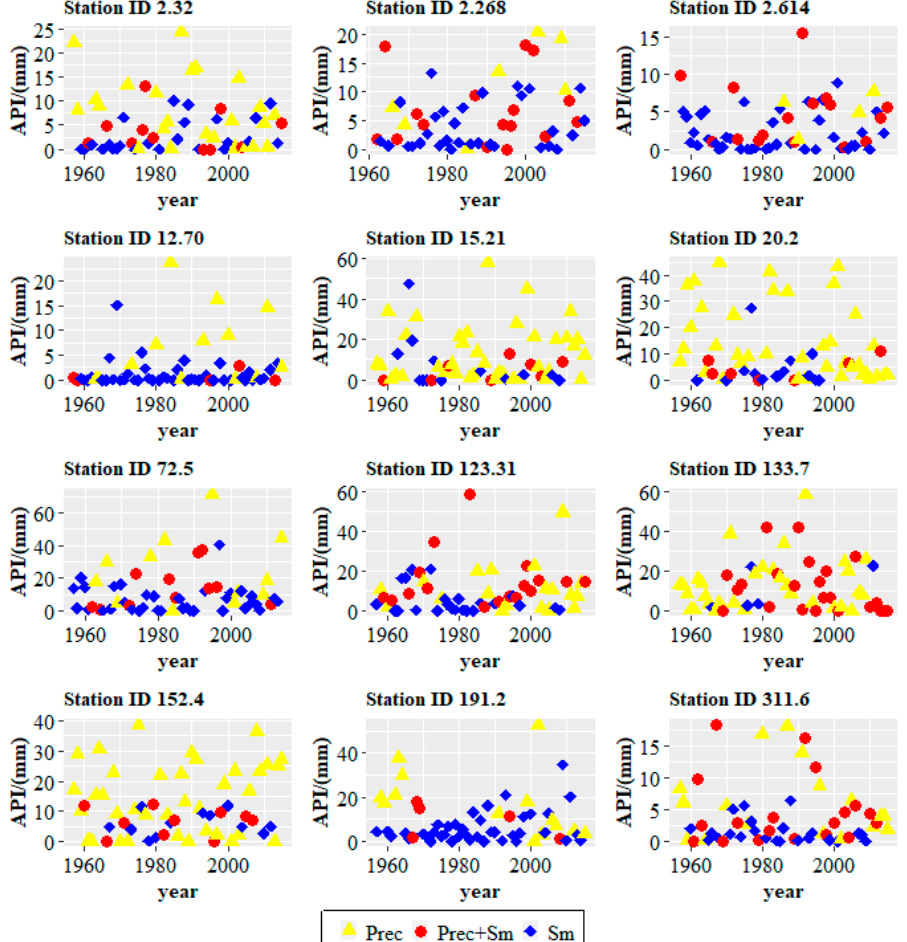
Figure 5. The API values associated with each flood event and flood types. The yellow triangle represents API value of rainfall floods (Prec), red dot represents API value of rain-on-snow floods (Prec+Sm), and diamond represents snowmelt flood (Sm).